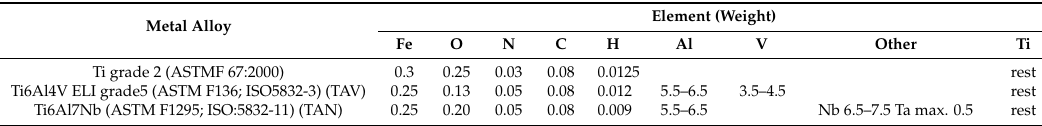
Table 1. Detailed manufacturer’s data on plates and screws used for testing.